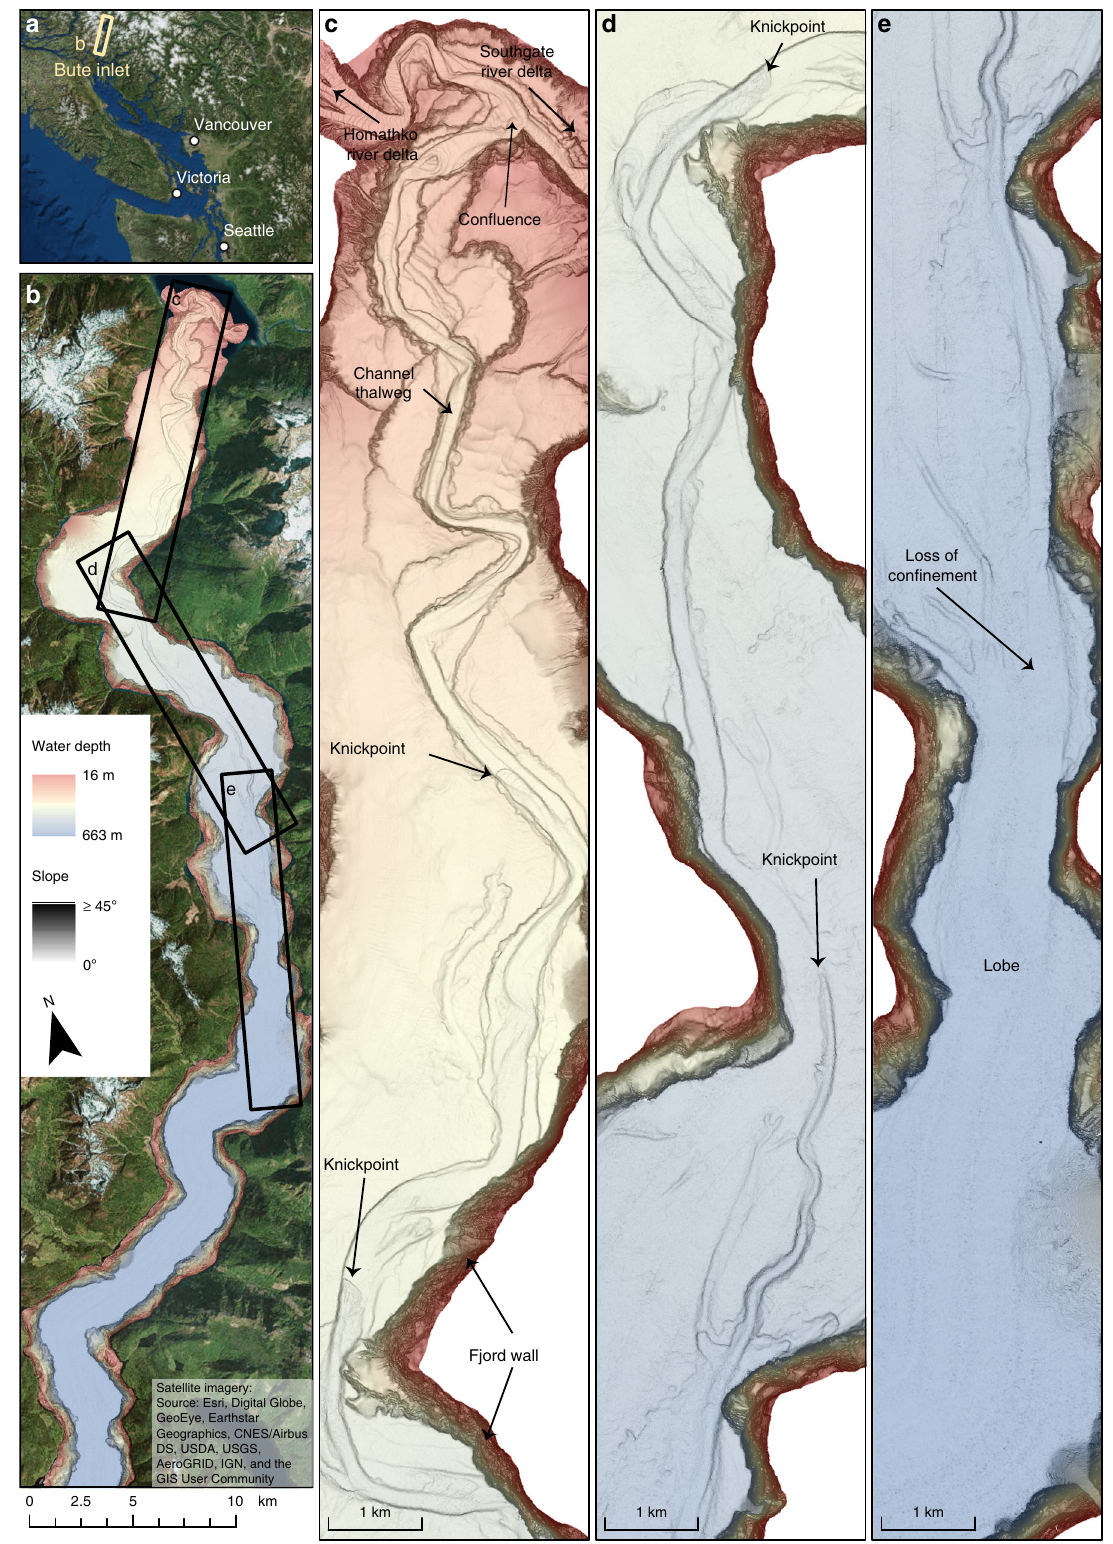
Fig. 1 Overview of the submarine channel system in Bute Inlet. a Location of Bute Inlet in British Columbia, Canada. b Map of Bute Inlet showing the location of more detailed images shown in panels c to e . Bathymetric surveys are presented here as maps of seabed gradient, which optimally visualize small and steep topographical features, such as knickpoints. Seabed gradient maps are then overlain by a transparent bathymetry map. c - e Detailed maps of the 40 km long submarine channel within Bute Inlet, showing the location of river deltas, knickpoints and lobe beyond the channel